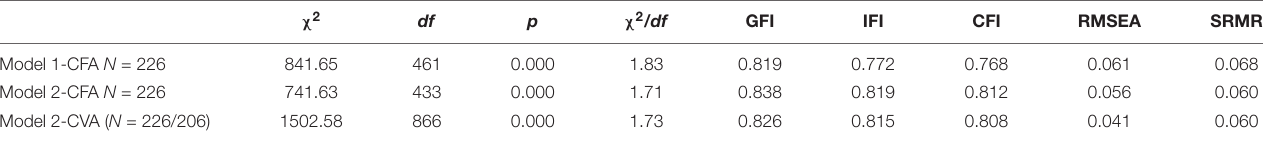
TABLE 3 | Goodness of fit statistics for the hierarchical confirmatory factor analysis (Model 1-CFA), the bi-factor confirmatory factor analysis (Model 2-CFA) and the bi-factor cross-validation analysis (Model 2-CVA). χ 2 df